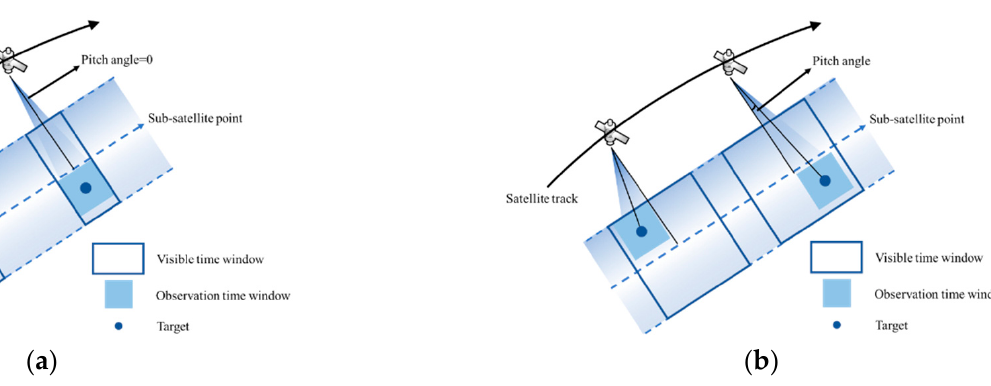
Figure 1. ( a ) CEOSs where the VTW is equivalent to the OTW; ( b ) AEOS where the VTW is usually longer than the OTW.